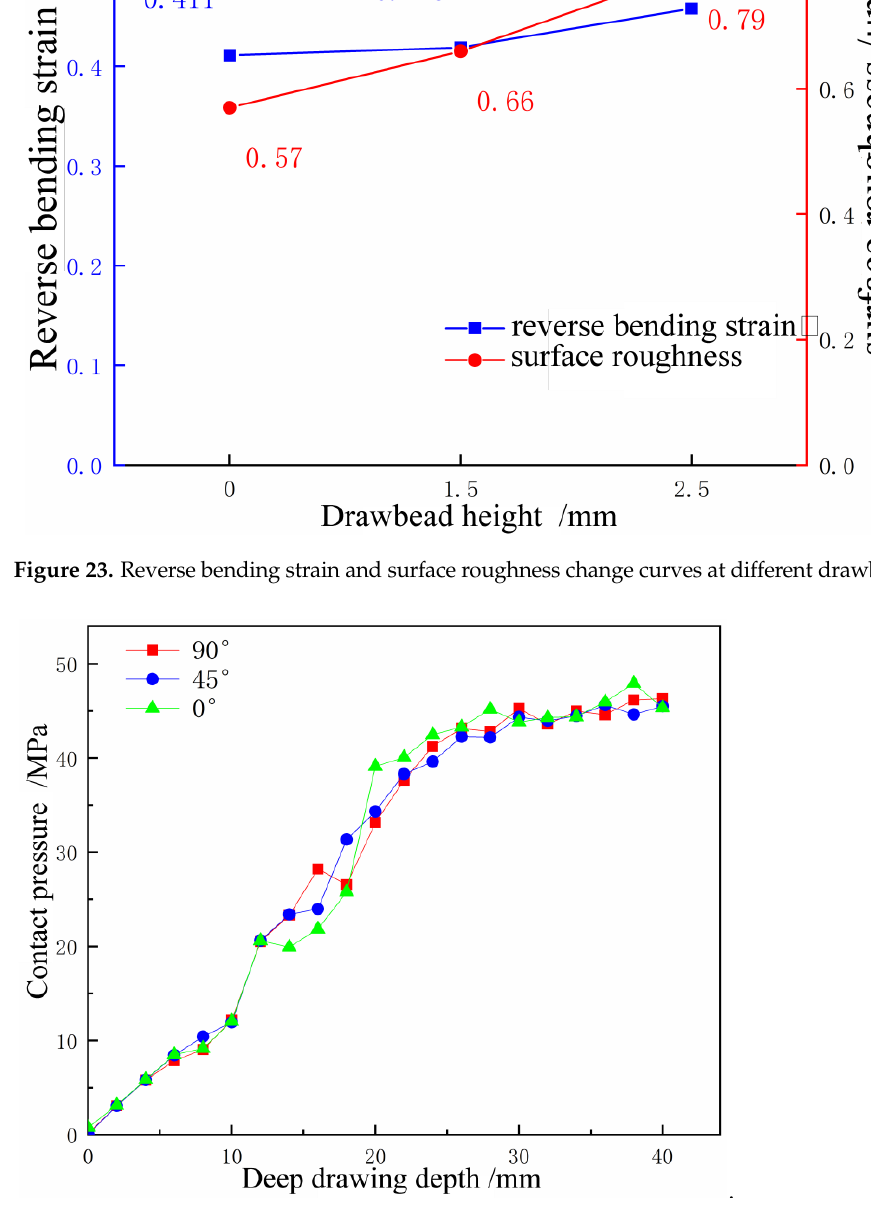
Figure 24. Draw depth–contact pressure curves at different rolling direction.